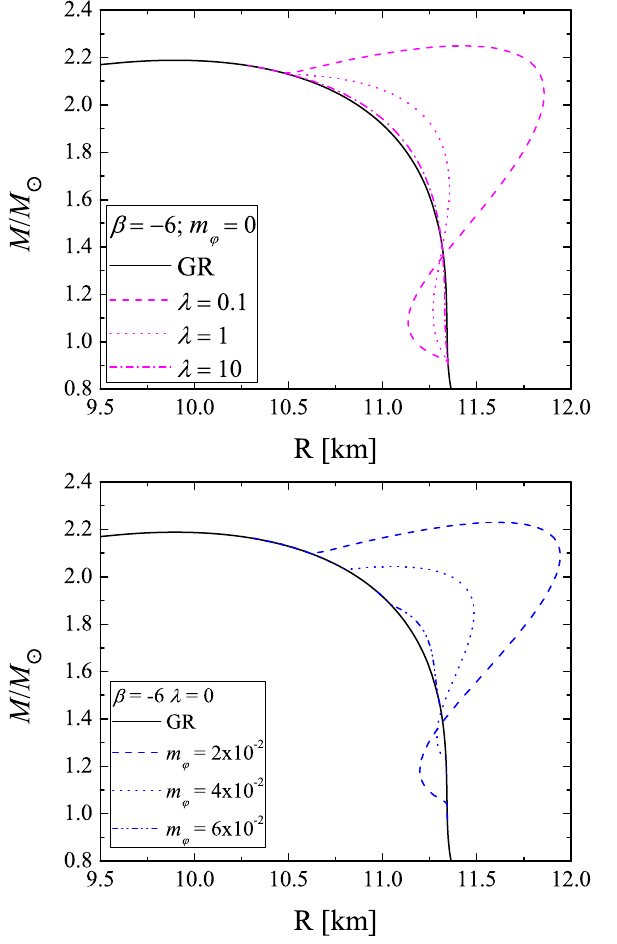
Fig. 4 Mass of radius relation for massless STT with self-interaction (top), and for massive STT without self-interaction (bottom). Both rela- tions are for β = − 6, and different values of the free parameter